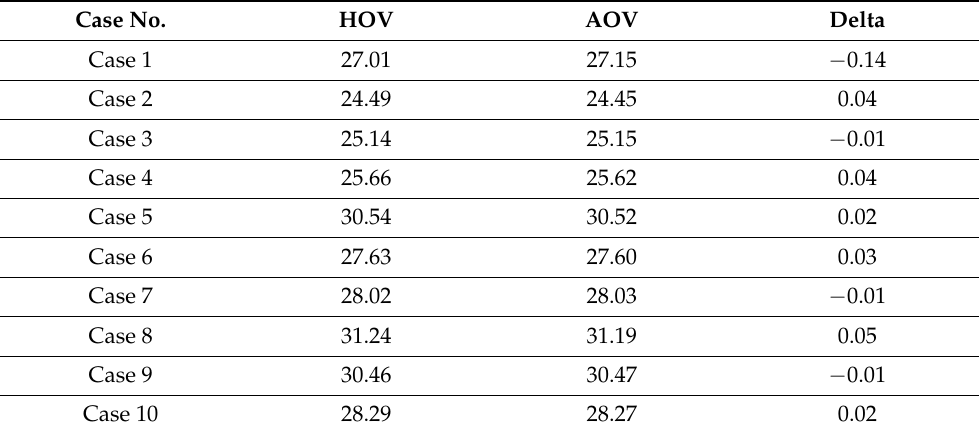
Table 2. Volume measurement of the bony